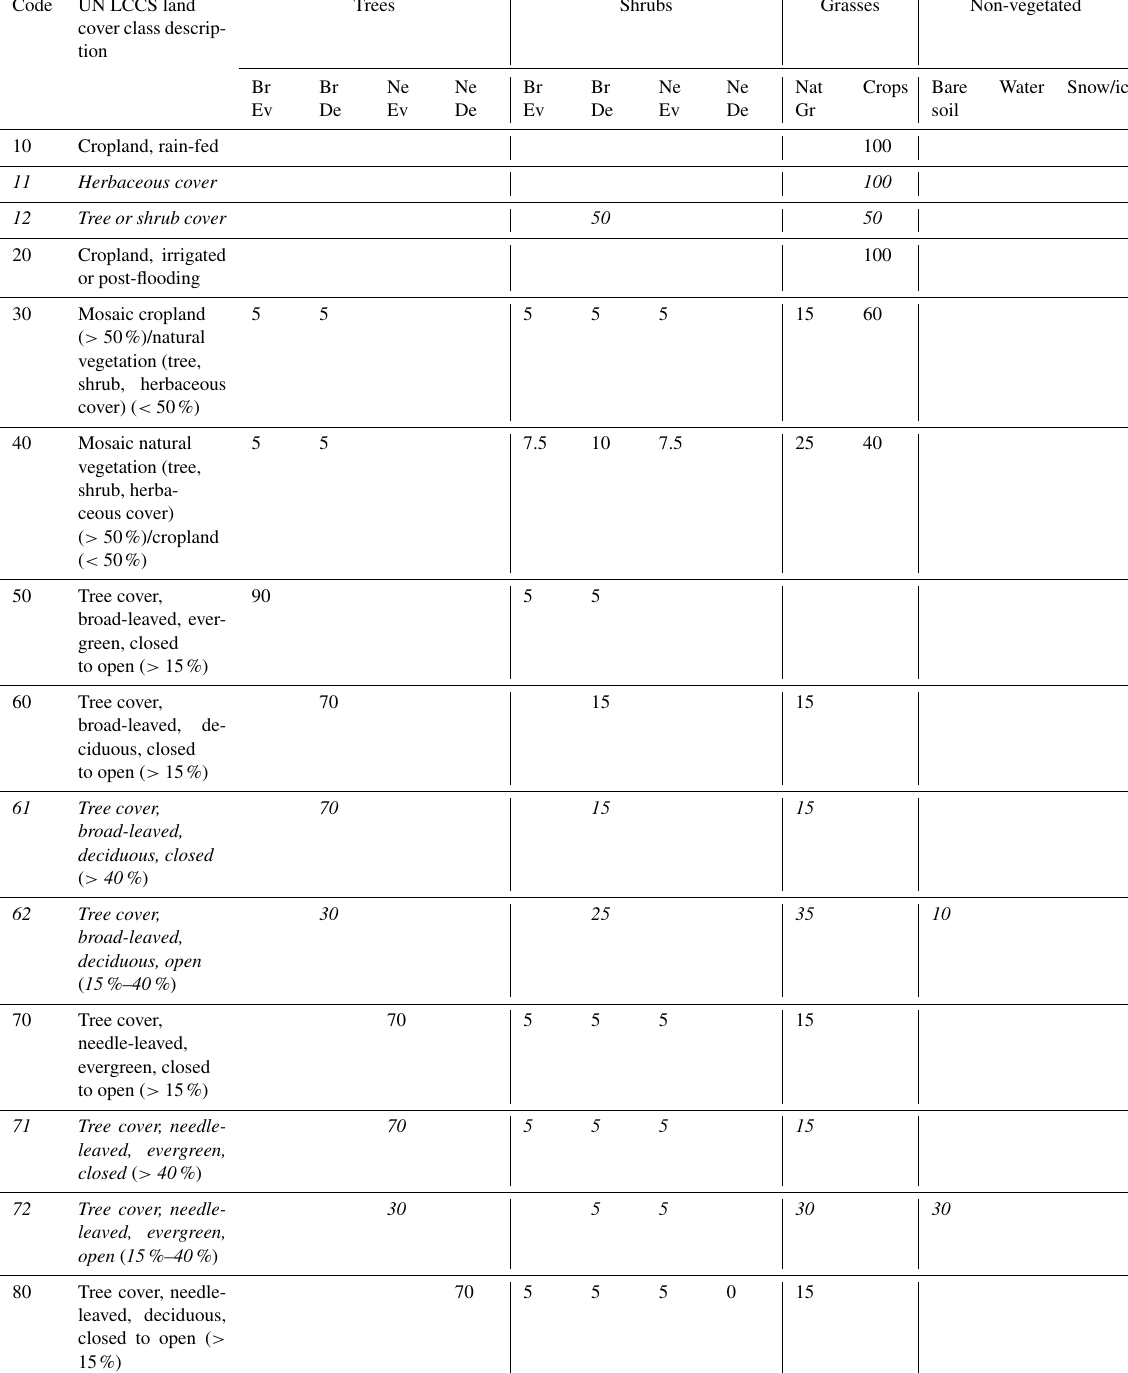
Table C1. Default land cover to plant functional type cross-walking table provided by the conversion tool with the level-1 UN LCCS classes and level-2 UN LCCS sub-classes in italics. The units are percentage coverage of each PFT per UN LCCS class (from Poulter et al.,